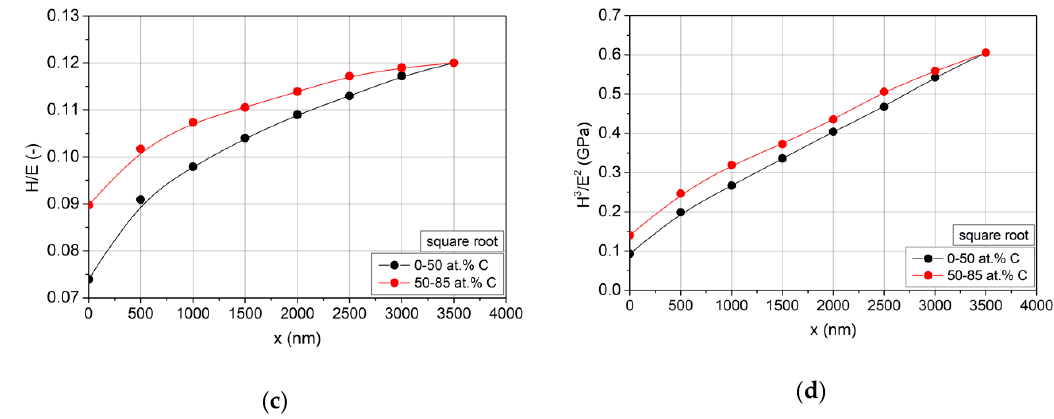
Figure 14. Profiles of changes in the values of H/E indices: ( a ) parabolic profiles, ( c ) square root profiles and H 3 /E 2 ; ( b ) parabolic profiles, ( d ) square root profiles for Zr–C coatings in carbon content ranges of 0–50 and 50–85 at.%.